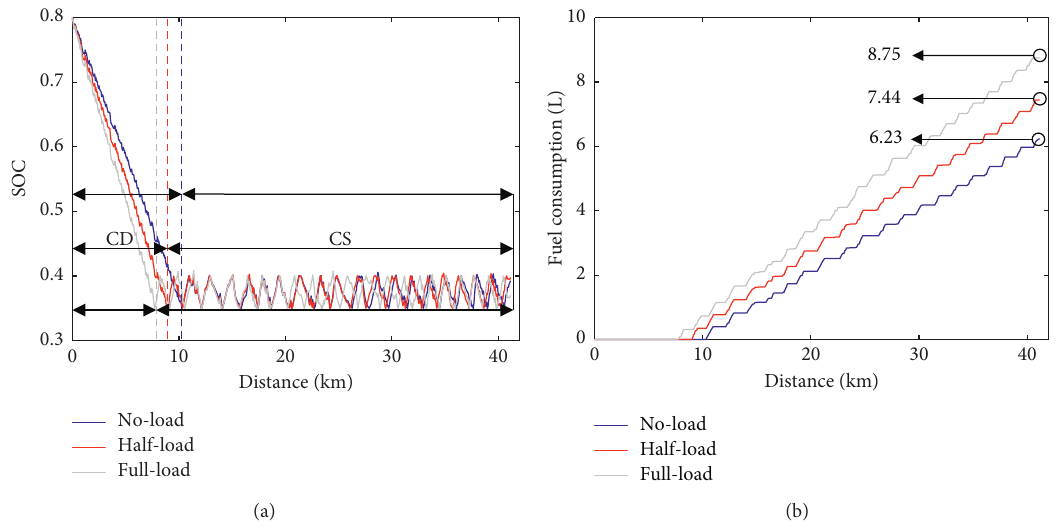
Figure 23: Impact of the passenger load on fuel consumption. (a) SOC changing and (b) fuel consumption.